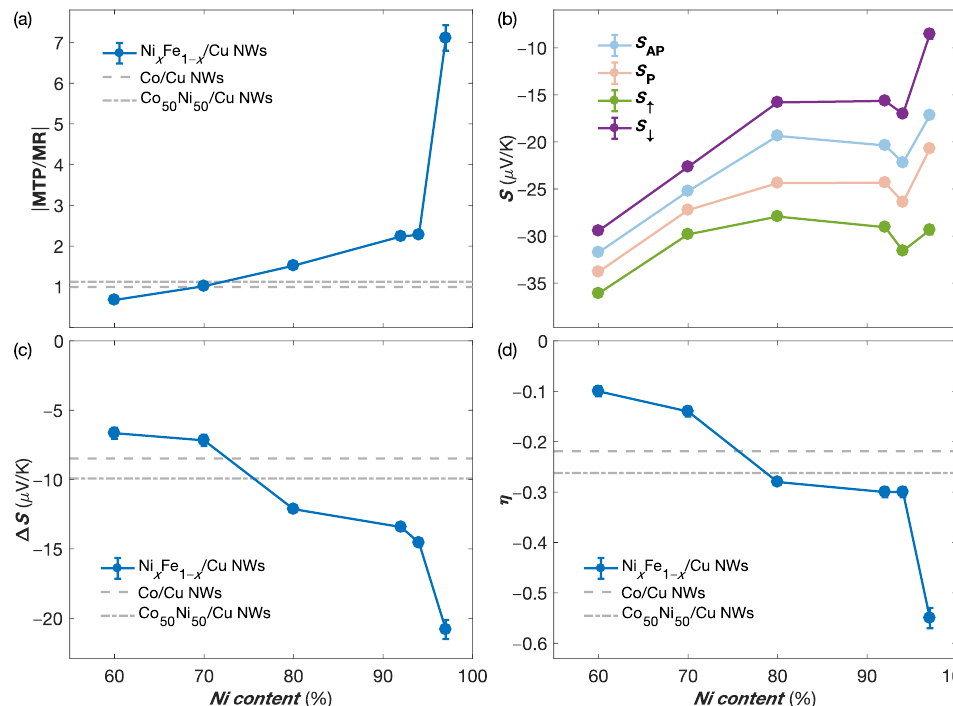
Figure 4. ( a ) | MTP/MR | ratio as a function of the Ni content at room temperature for Ni x Fe 1 − x /Cu NW networks. The dashed and dot-dashed grey lines correspond to the | MTP/MR | values previously reported for Co/Cu [16] and Co 50 Ni 50 /Cu [15] NW networks, respectively. ( b ) Seebeck coefficients in the anti-parallel (AP, in light blue) and parallel (P, in light red) states, together with the calculated Seebeck coefficient for spin up (in green) and spin down (in purple) electrons using Equations (4) and (5) as a function of the Ni content of Ni x Fe 1 − x /Cu NW networks at room temperature. ( c ) Varia- tion of ∆ S = ( S ↑ − S ↓ ) with the Ni content at room temperature. ( d ) Room temperature values of the spin asymmetry coefficient for the Seebeck coefficient η as a function of the Ni content. The dashed and dot-dashed grey lines in ( c , d ) corresponds to the ∆ S and η values reported for Co/Cu [16] and Co 50 Ni 50 /Cu [15] NW networks,